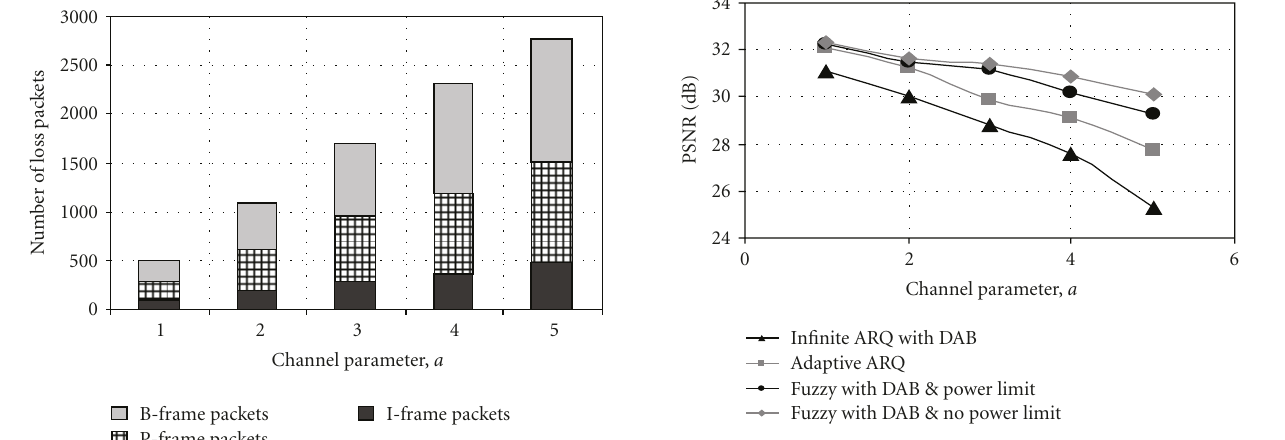
Figure 15: Contribution of I-, P-, and B-frame packet losses to total packet loss in the infinite ARQ with DAB scheme.